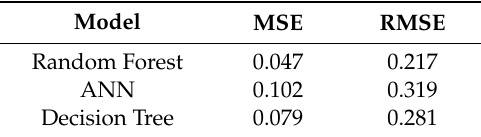
Table 3. Model comparison results.